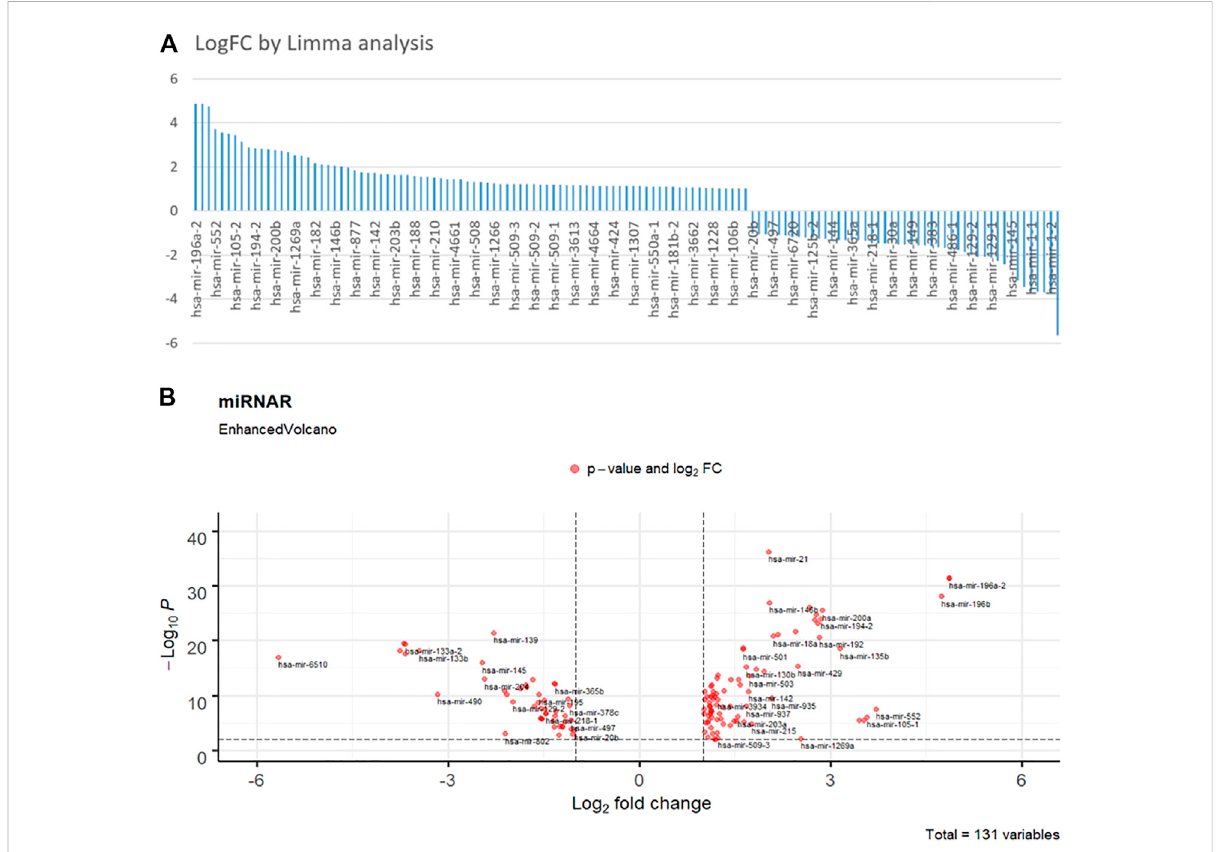
FIGURE 2 (A) Fold change histogram table of the miRNA candidates. (B) Enhanced Volcano picture of 131 selected miRNAs. The deep red dots are overlapped miRNAs. Top right and left dots are those signi fi cance different